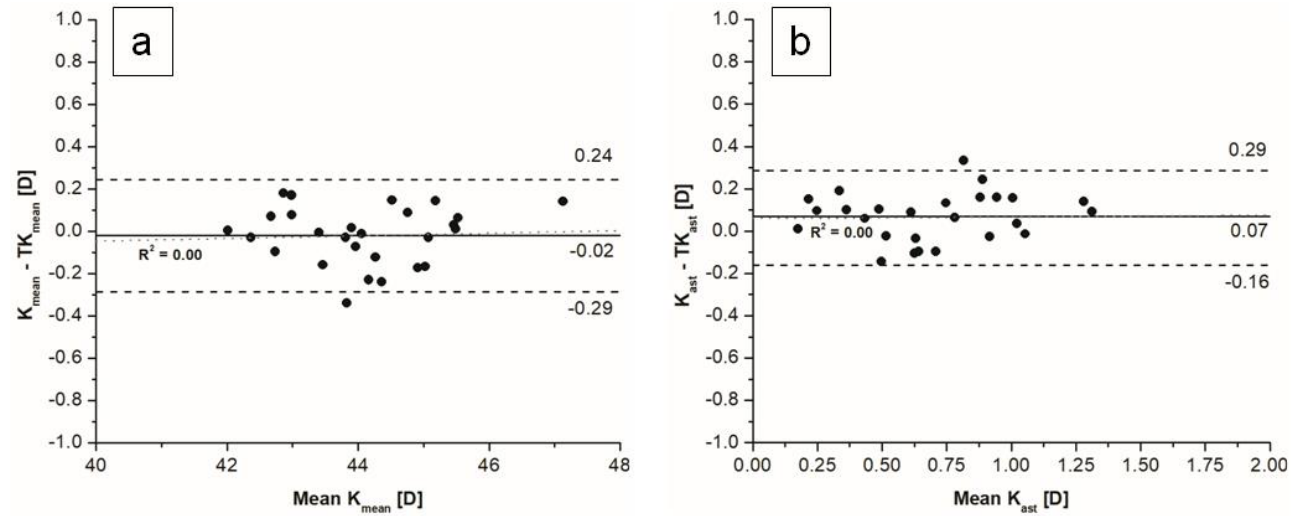
Figure 1. Bland – Altman plots of comparison between K and TK using ( a ) mean values, ( b ) astigma- tism magnitude.